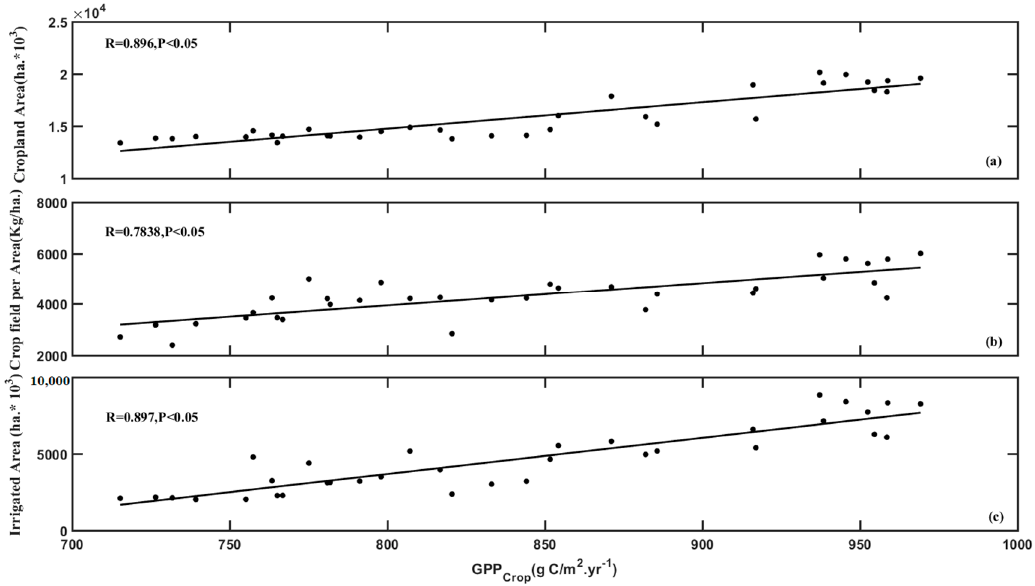
Figure 8. Relationship of GPP GS with ( a ) Cropland Area, ( b ) Crop Yield per Area, and ( c ) Irrigated Area.